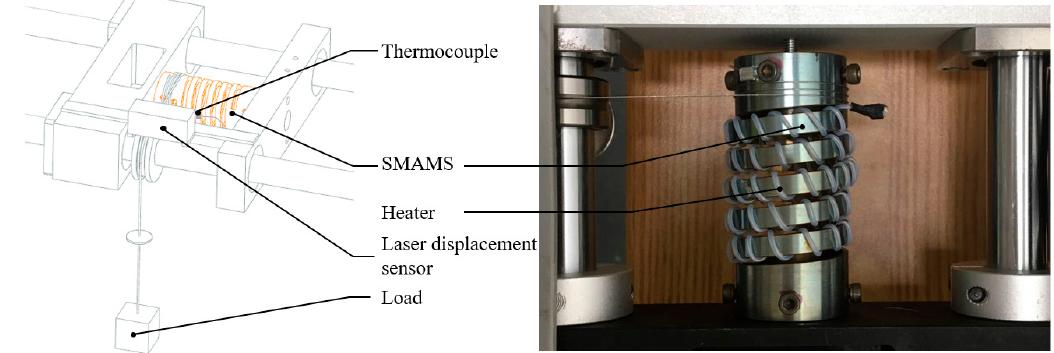
Figure 8. Detailed experimental setup for the thermomechanical test.